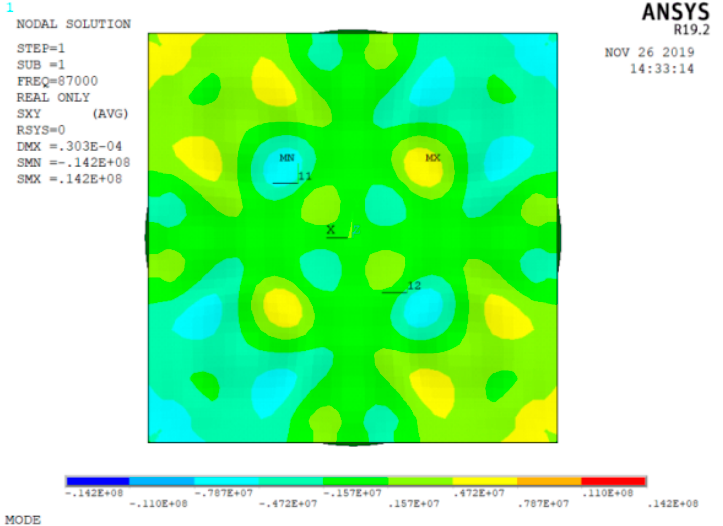
Figure 11. Cloud image of the distributions of shear stress at the adhesive interface (the thickness of the PZT patch is 1 mm).